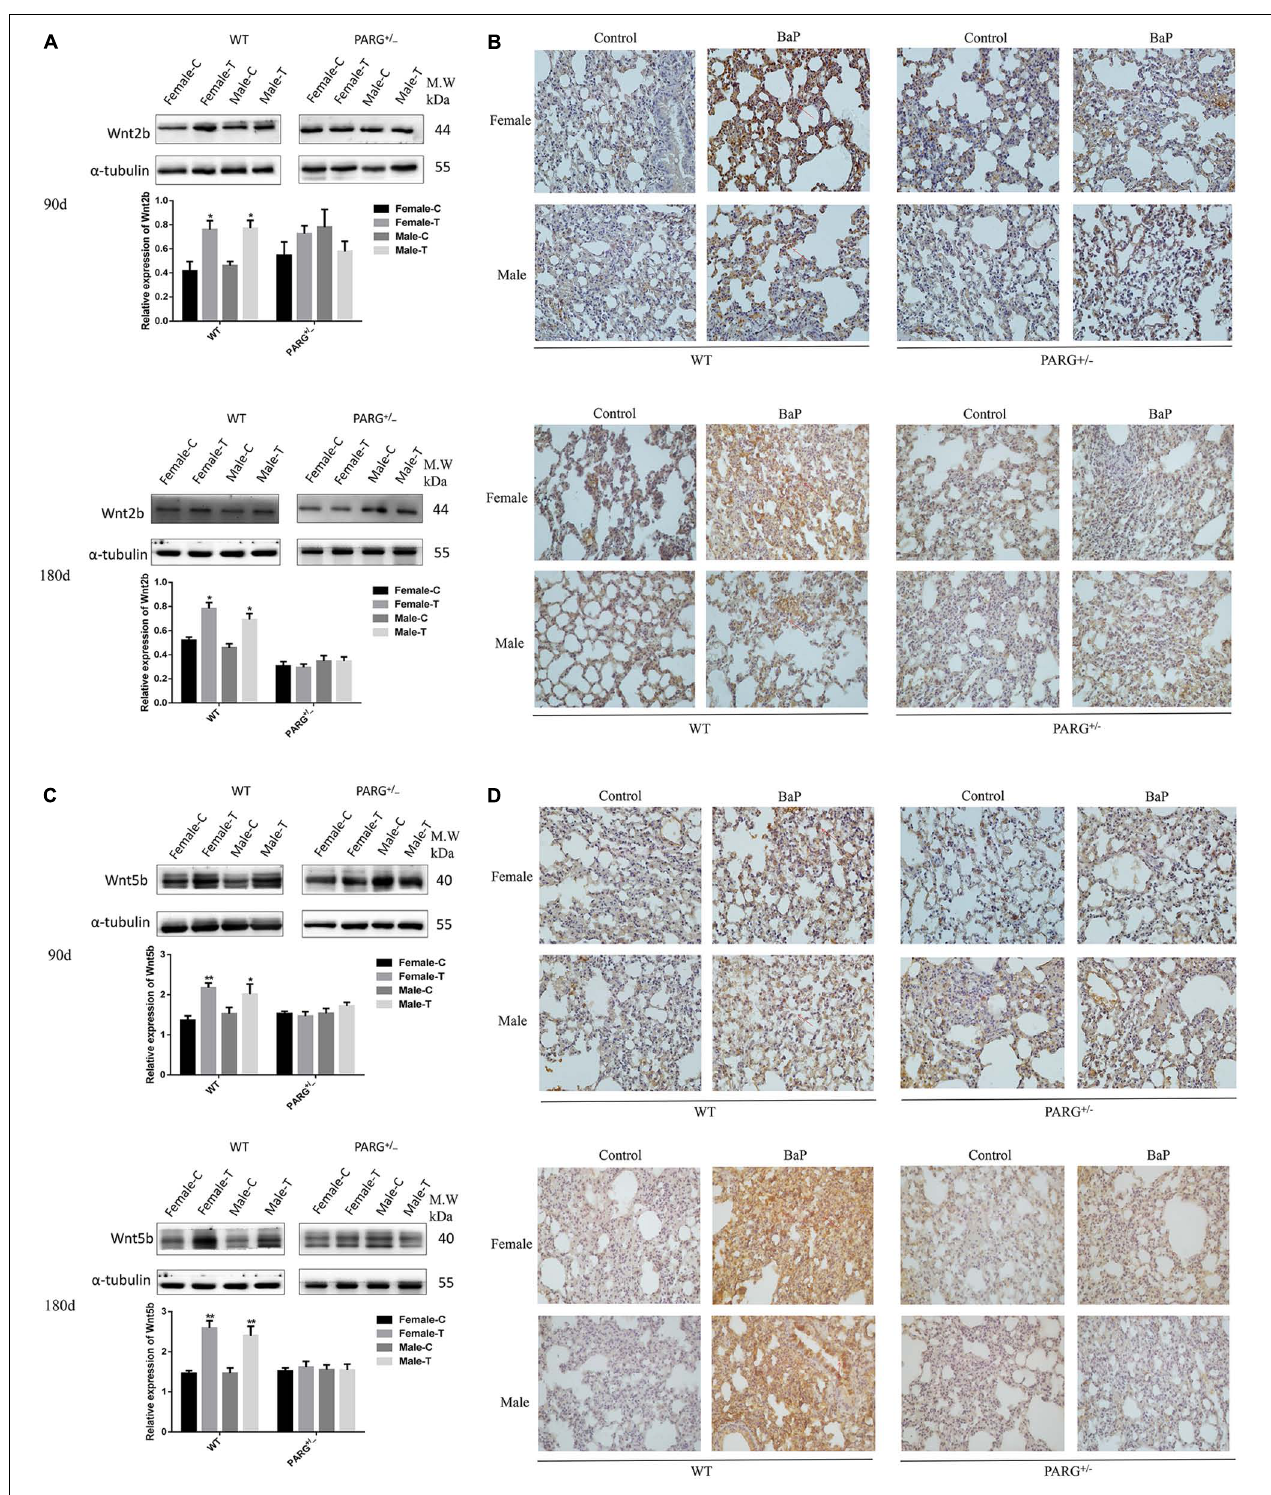
FIGURE 5 | PARG silencing inhibits the expression of Wnt2b and Wnt5b protein in lung tissues after BaP inhalation exposure. Expression of Wnt2b and Wnt5b protein in lung tissues detected by Western blotting and immunohistochemistry. (A) Western blotting of Wnt2b expression. (B) Immunohistochemical staining of Wnt2b ( × 200). Protein expression levels are reflected by the area and depth of brownish yellow. (C) Western blotting of Wnt5b expression. (D) Immunohistochemical staining of Wnt5b ( × 200). Red arrows indicate Wnt2b and Wnt5b localization in the cytoplasm. Female-C, control untreated female mice; Female-T, treated female mice; Male-C, control untreated male mice; Male-T, treated male mice. ∗ P < 0.05, ∗∗ P < 0.01, significant up-regulation in treated vs. control mice.